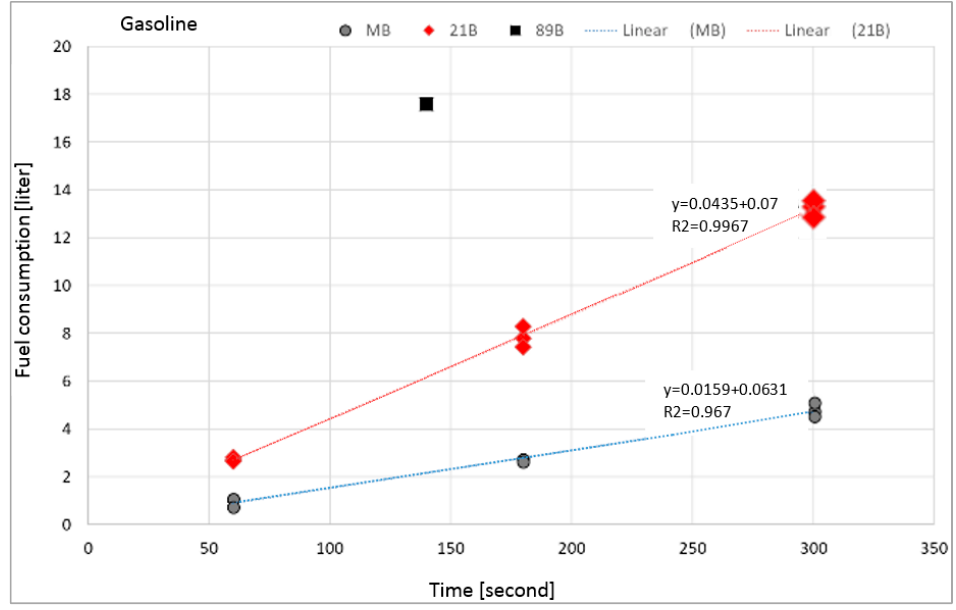
Figure 3. Variation of fuel consumption as a function of time.